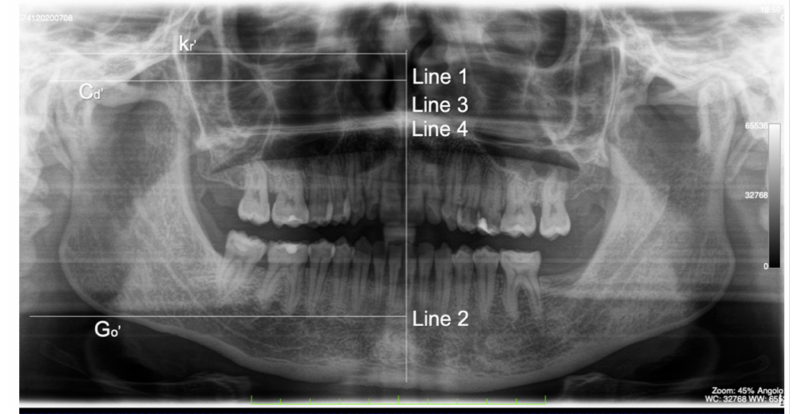
Figure 8. Diagram of the Levandoski panographic analysis on the panoramic X-ray (age 23). CBCT imaging was obtained to evaluate the coronoid process changes in comparison to scans of 13 years before (Figure 9). The mouth opening remained constant whereas the joint disks and condyle at the MRI examination showed an ankylotic aspect despite the acceptable position (Figure 10).